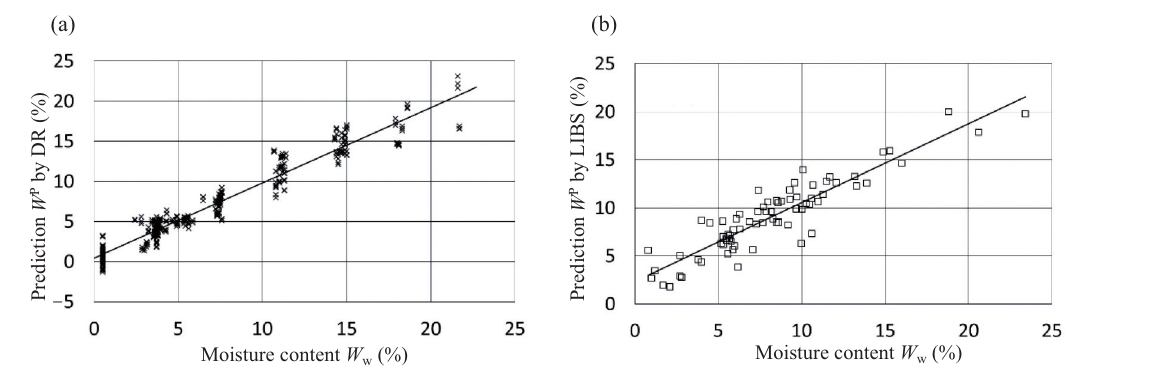
Fig. 6. (a) DR results: cross validation of moisture content W P . (b) LIBS results: cross validation of moisture content W P ; data taken from [8].